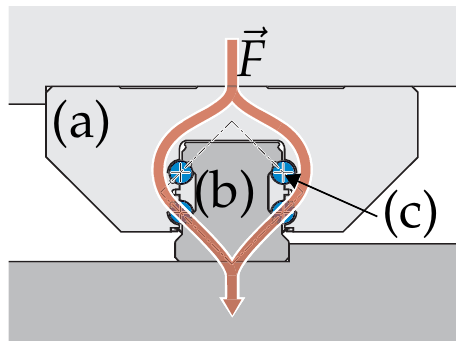
Figure 1. Sketch of a linear guide bearing with a runner block ( a ) on a rail guide ( b ) connected via rolling elements ( c ). With an exemplary force flux (cid:126) F .